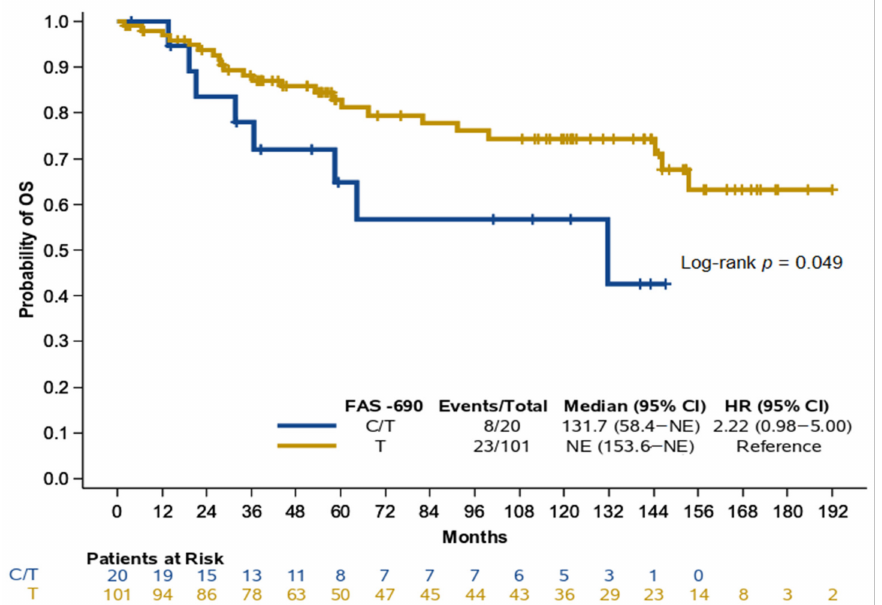
Figure 2. Kaplan–Meier curves for OS according to FAS − 690 genotypes in NPC patients. HR: hazard ratio, CI: confidence interval, NE: not estimable.